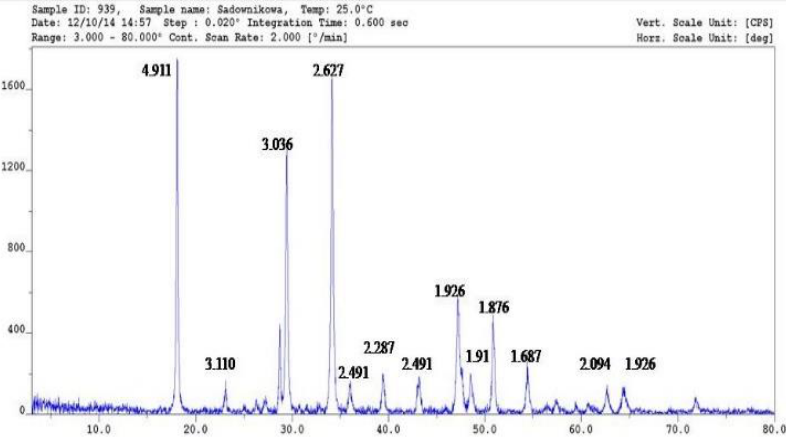
Figure 5. X-ray diffraction pattern of a lime composite in the presence of a synthetic zeolite additive.